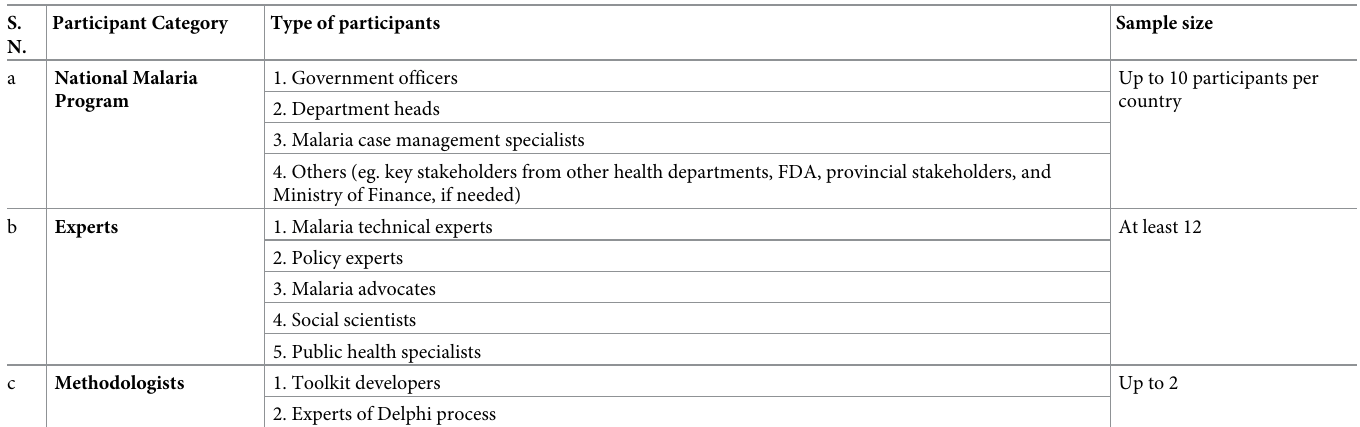
Table 1. Participants in OAT development process.